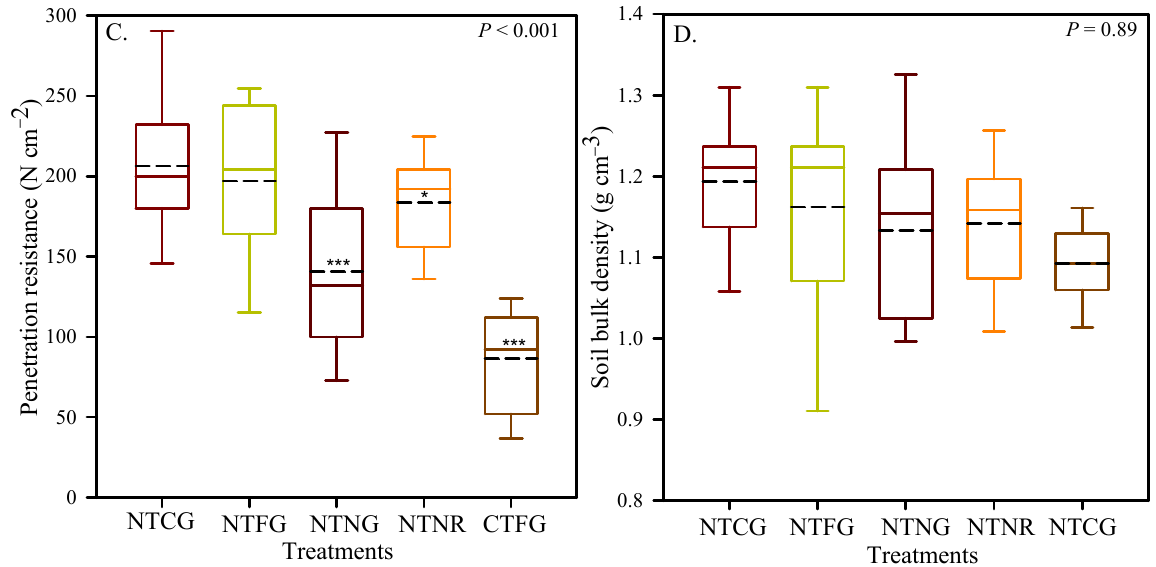
Figure 2. Box-whisker plots for soil temperatures ( A ), soil water content ( B ), penetration resistance ( C ) and soil bulk density ( D ) at 0.05 m soil depth from conventional tillage with free grazing (CTFG), no-tillage with free grazing (NTFG), no-tillage with no grazing (NTNG), no-tillage without crop residue mulching (NTNR) and no-tillage with controlled grazing (NTCG). Plain lines correspond to 10th, 25th, median, 75th , and 90th percentiles; short dash lines to the mean. Significant differences from NTCG mean as a control to the other treatments indicated by *, **, ***, representing p value of < 0.05, <0.01, 0.001, respectively. N = 120, 27, 45, for soil temperatures, soil water content, penetration resistance, and soil bulk density, respectively.